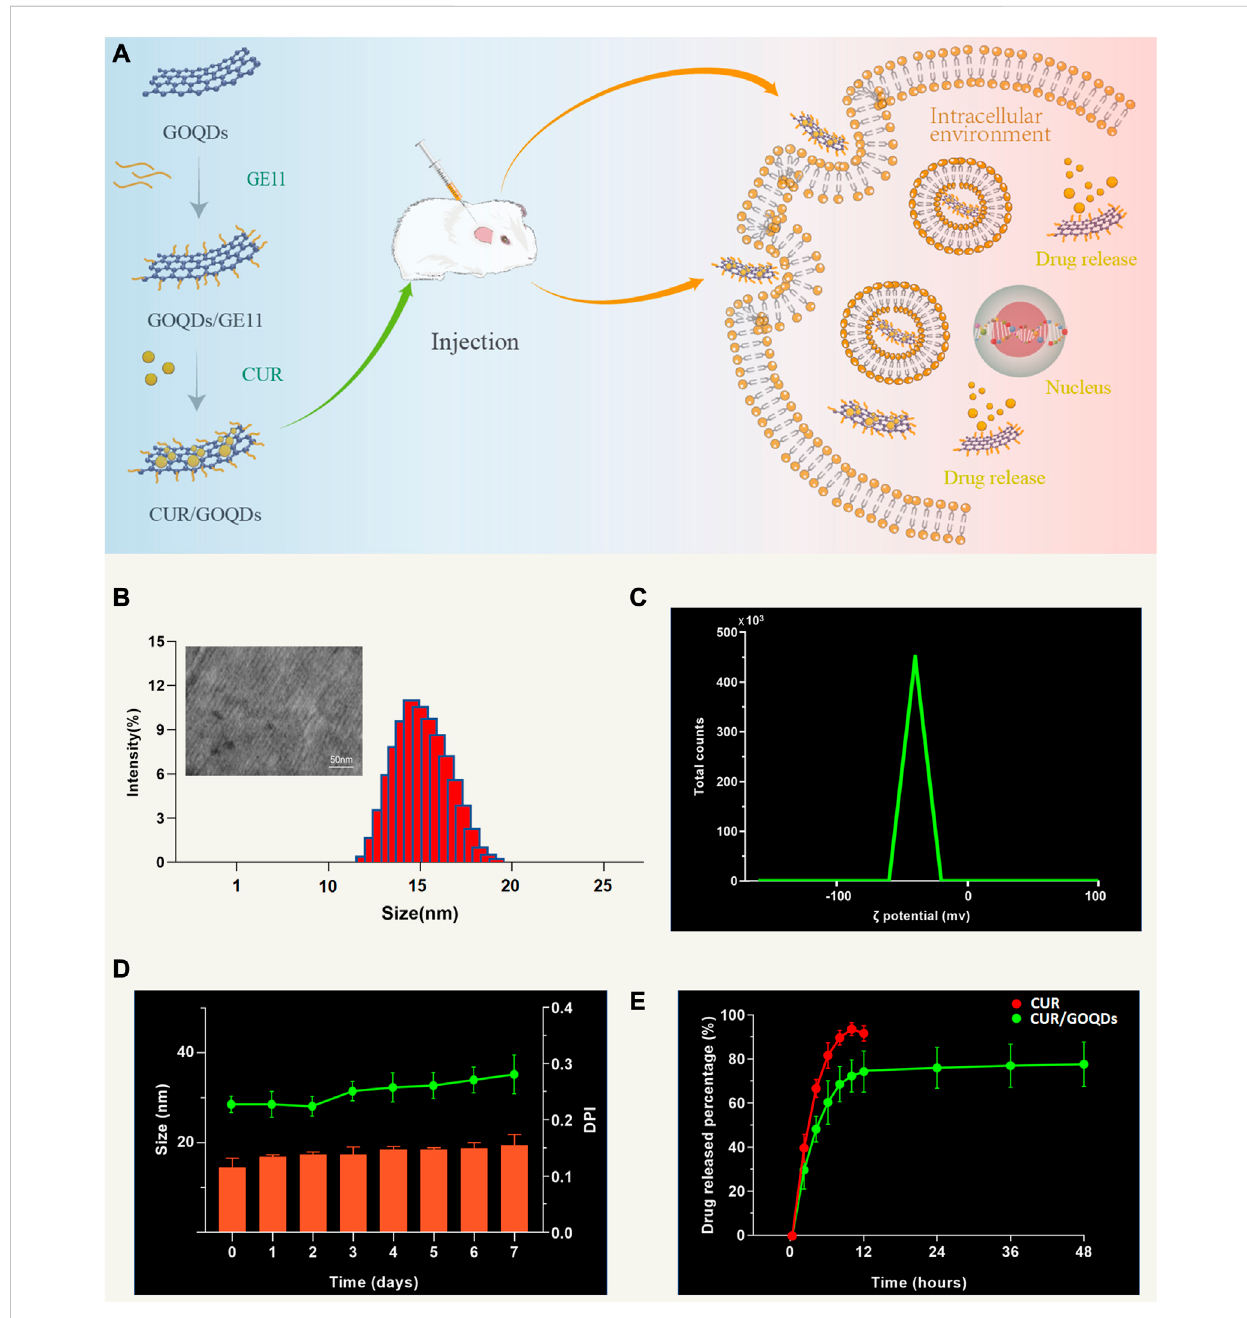
FIGURE 1 Preparation and characterization of CUR/GOQDs nanoparticles. (A) Schematic description of the preparation and structure of CUR/GOQDs. GOQDs were synthesized by an improved Hummer ’ s method. CUR was transported to cells through the CUR/GOQDs complex to obtain potential otoprotective effects. (B) TEM image of CUR/GOQDs and particle distribution (bars in TEM image represent 50 nm). (C) The ζ potential of CUR/GOQDs showedanegativecharge. (D) ParticlesizeandvaluesofPDIatdifferentdays. (E) CumulativereleasecurvesoffreeCURandCUR/GOQDsincochlea perilymph at different time intervals. (PDI, Polydispersity index; TEM, Transmission electron